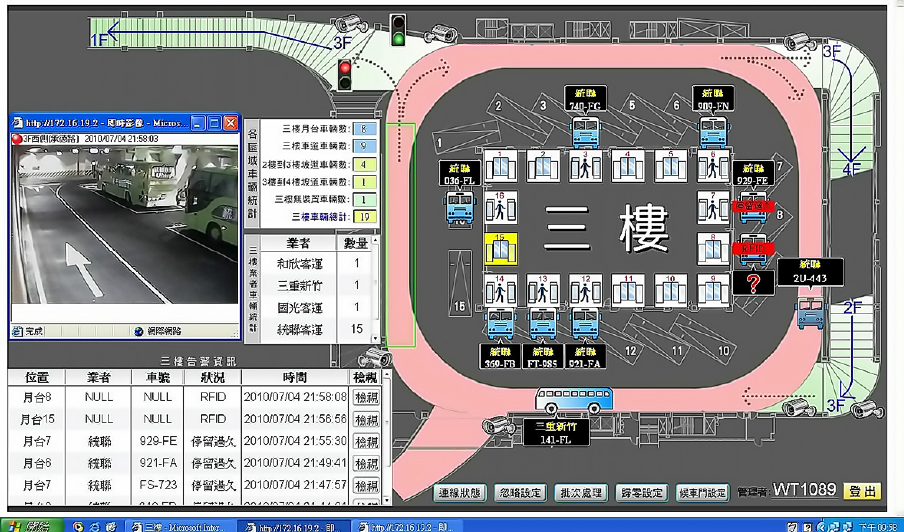
Figure 3. The interface of the monitoring system (third floor) (in